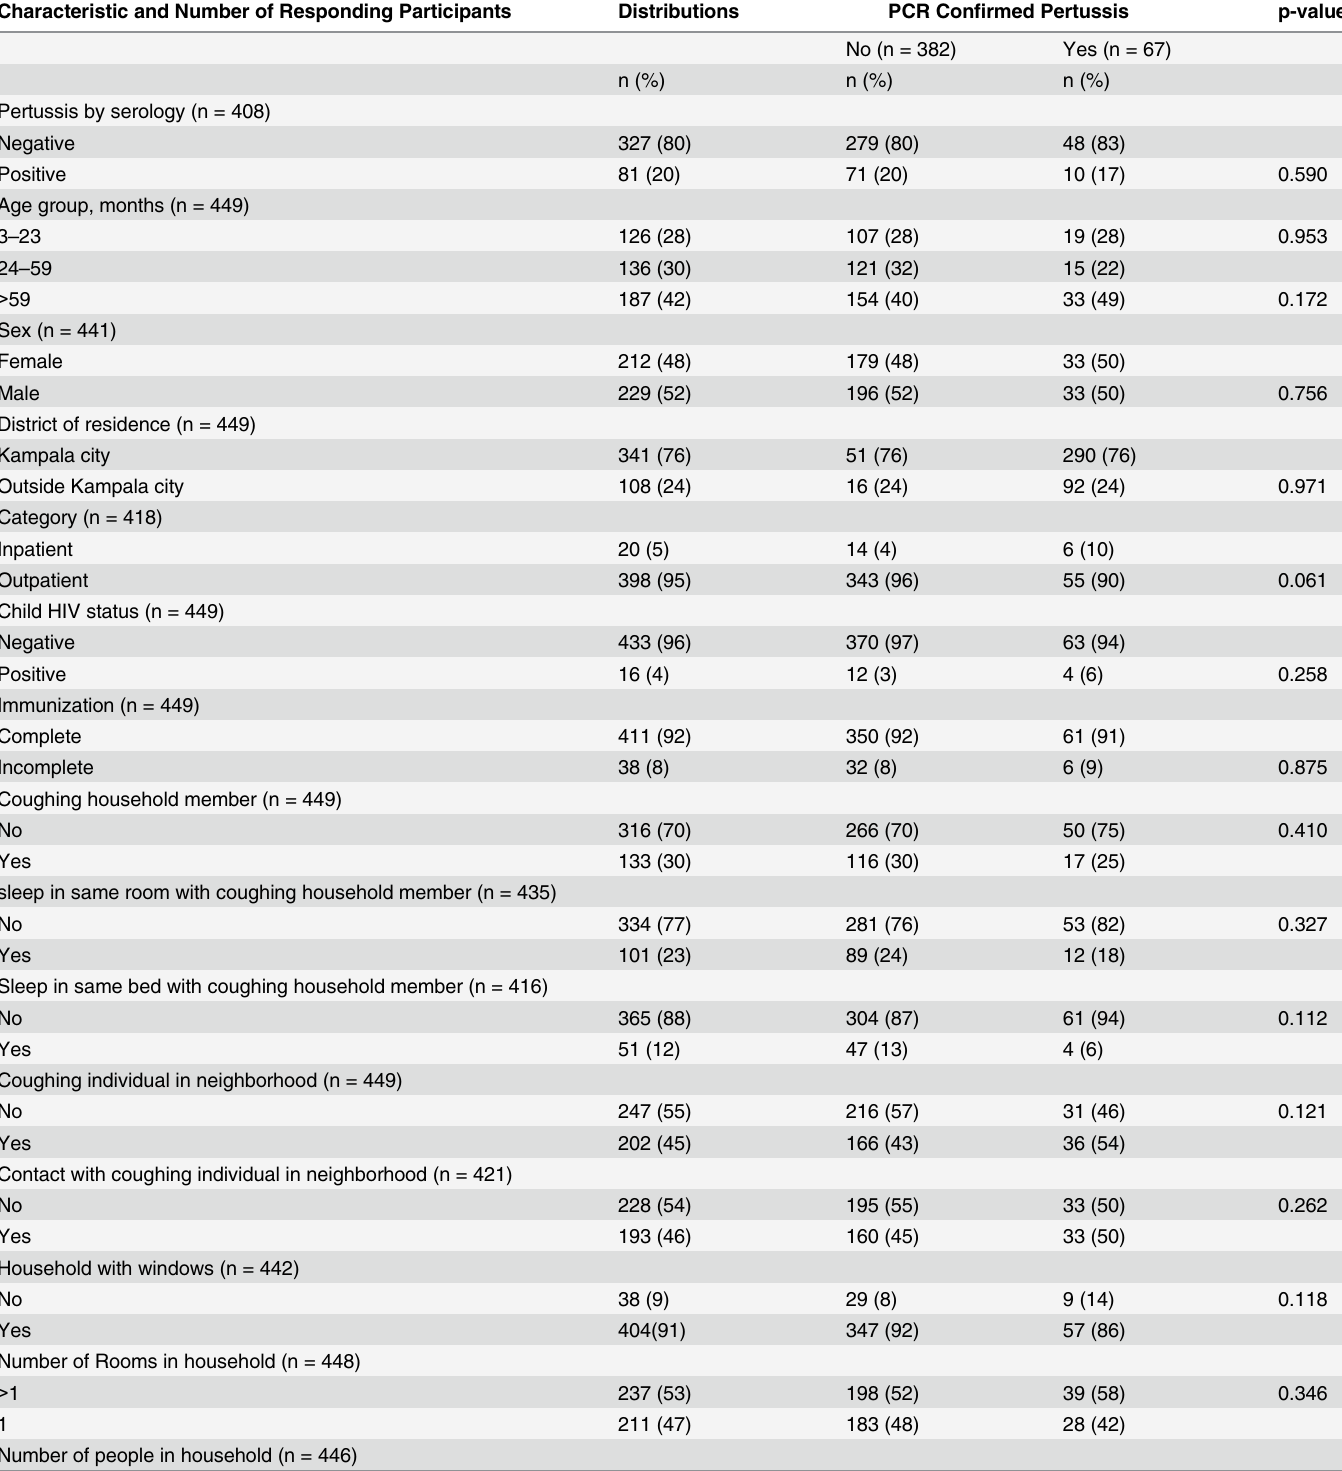
Table 1. Serology for pertussis, host and environmental factors associated with confirmed pertussis by PCR among 449 children at a national re- ferral teaching hospital in Uganda. Characteristic and Number of Responding